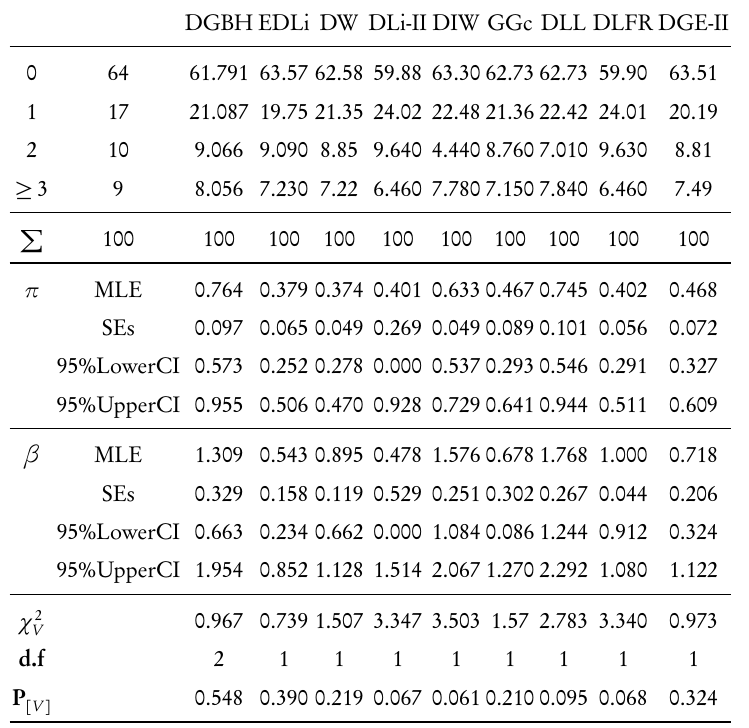
and P [ for the carious teeth data V ] V